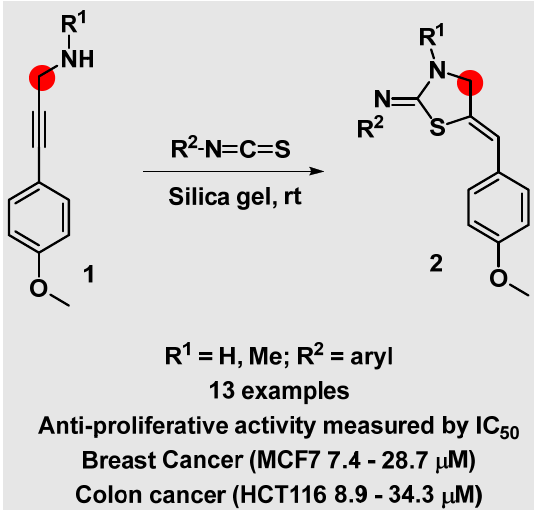
Figure 2. Approved drugs containing the thiazolidine core